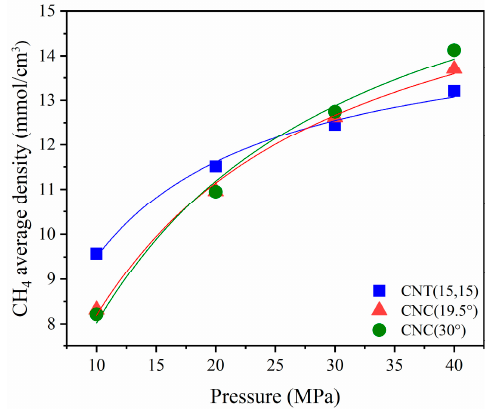
Figure 3. CH 4 average density in CNT/CNC versus pressure. T = 338 K. Dots represent simulated CH 4 average density, whilst lines represent the fitted Langmuir adsorption isotherm.